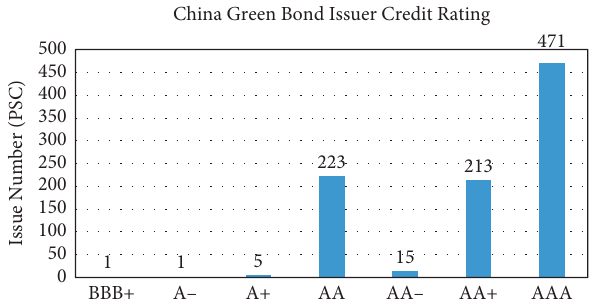
Figure 3: Credit Rating of China’s Green Bond Issuers (Data source: wind, compiled by the author).